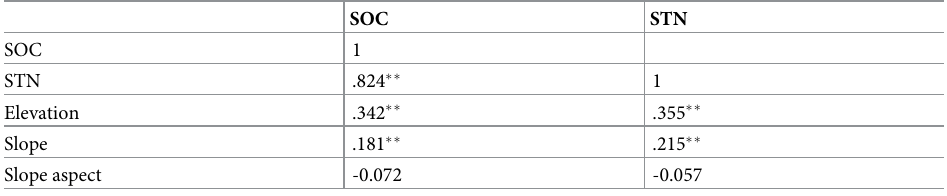
Table 5. Bivariate correlations between the studied variables. SOC STN SOC 1 STN .824 �� 1 Elevation .342 �� .355 �� Slope .181 �� .215 �� Slope aspect -0.072 -0.057 �� Correlation is significant at the 0.01 level